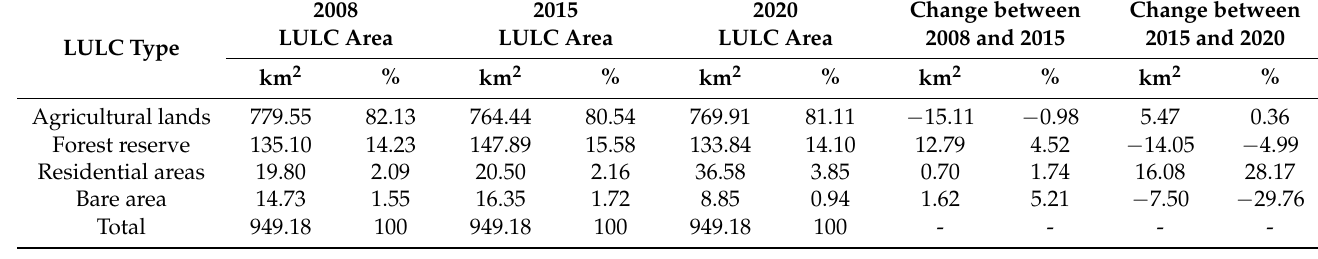
Table 3. Comparison of areas and pattern of changes in LULC classes between 2008, 2015, and 2020. LULC Type